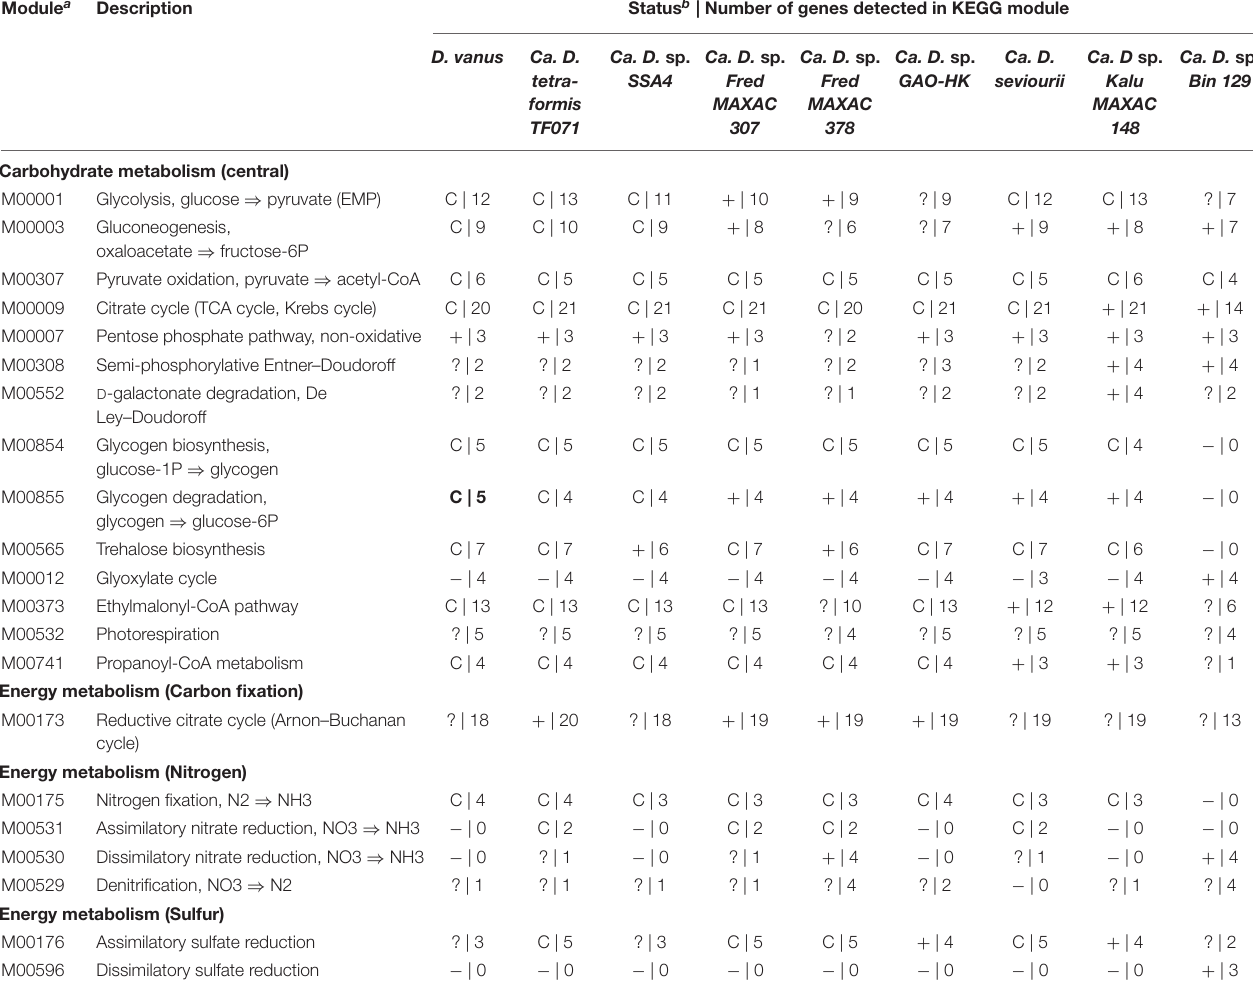
TABLE 3 | Summary of KEGG modules detected in genomes of members of genus Defluviicoccus. Module a